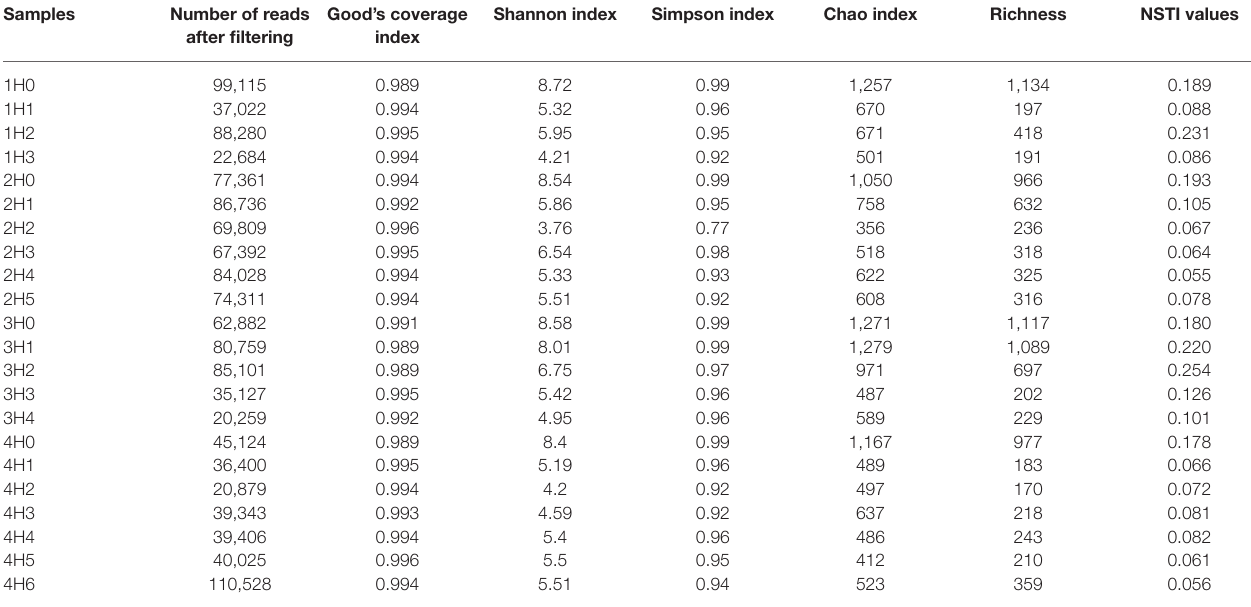
TABLE 2 | Number of filtered sequences, diversity indexes (Shannon, Simpson, and Chao), richness related with observed operational taxonomic units (OTUs), and Nearest Sequenced Taxon Index (NSTI) scores in the sediment samples. Samples Number of reads after